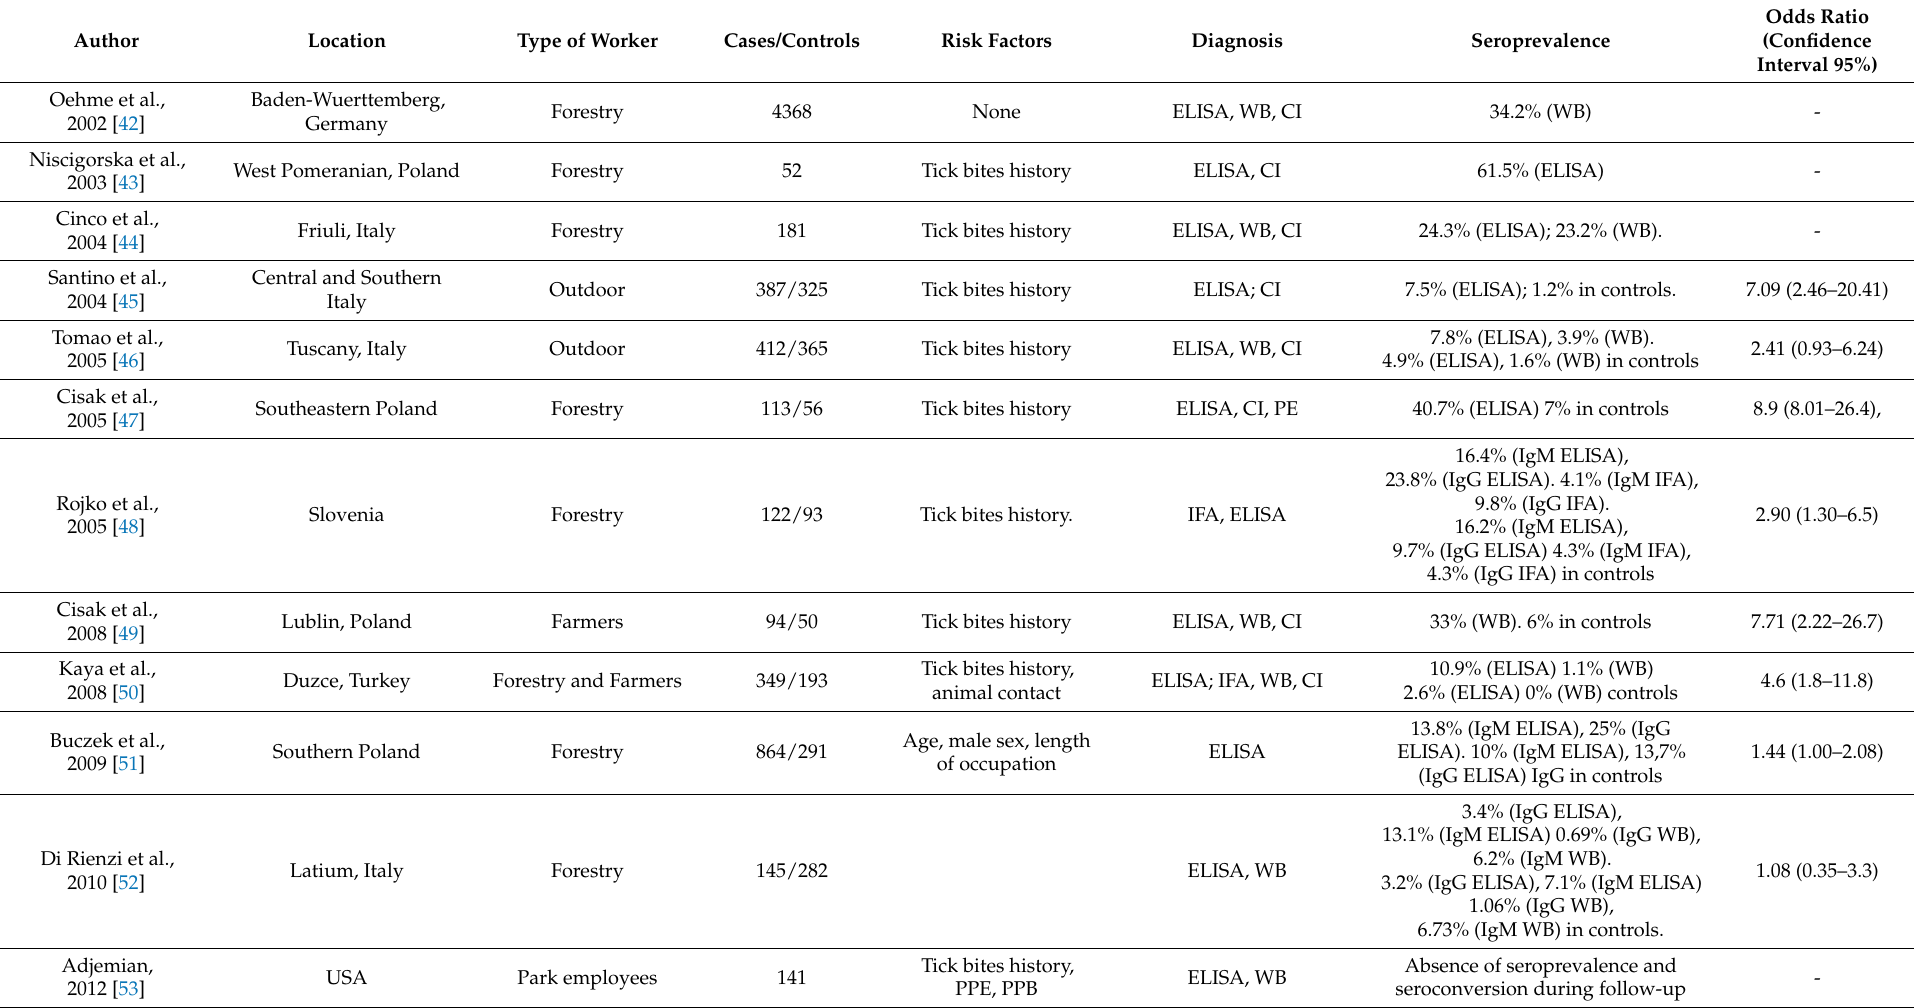
Table 1. Summary of the studies included in the systematic review ( n =